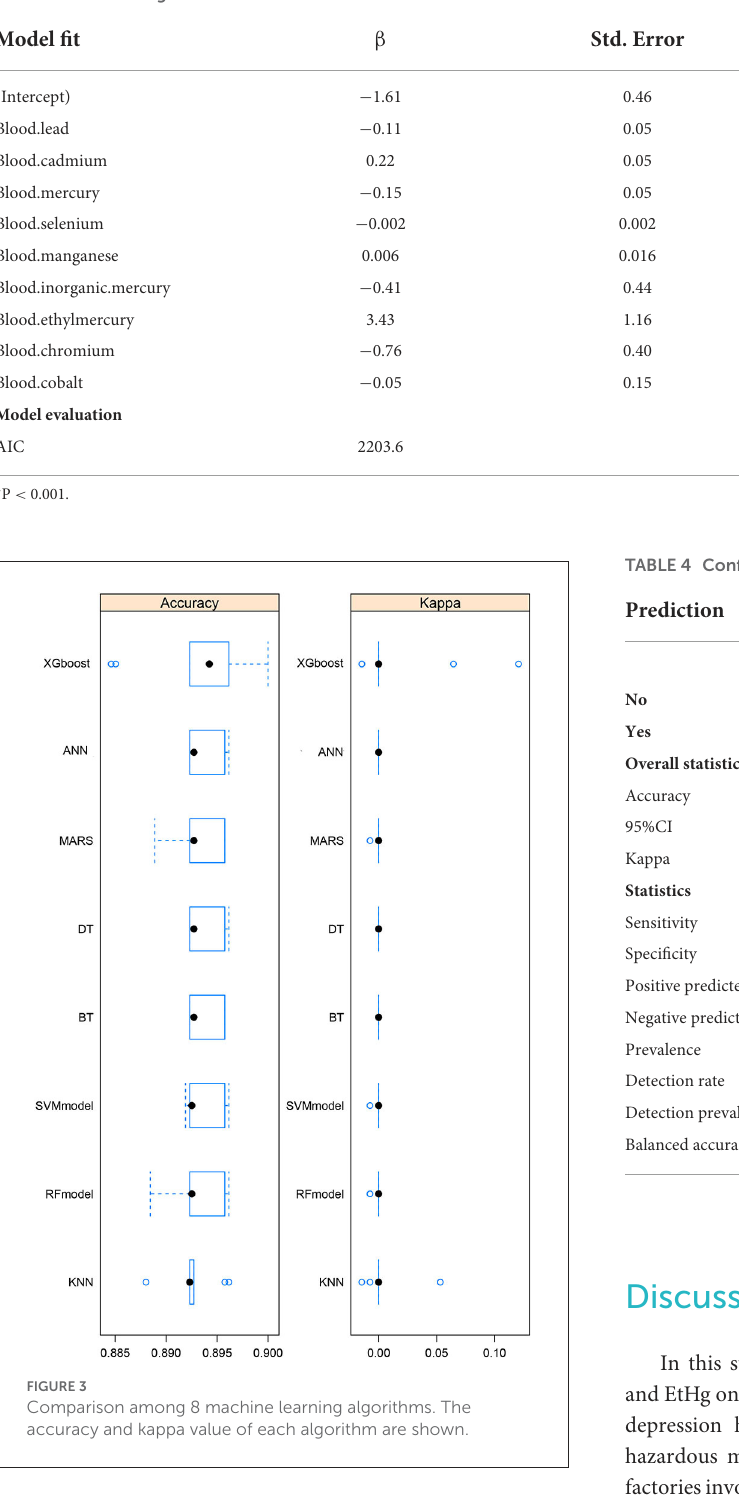
10 inputs of environmental heavy metals, so as to predict the outcome of depression.